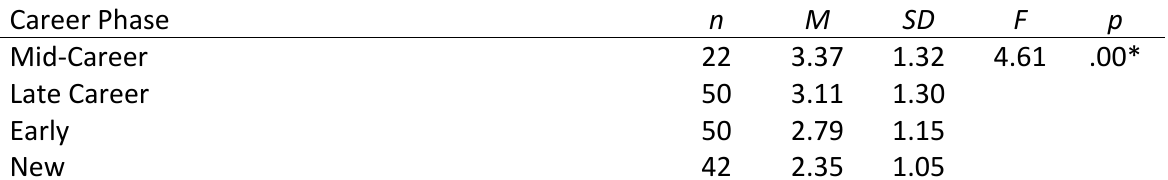
One-way Analysis of Variance for Perceived Usefulness of Social Media by Teacher Career Phase Career